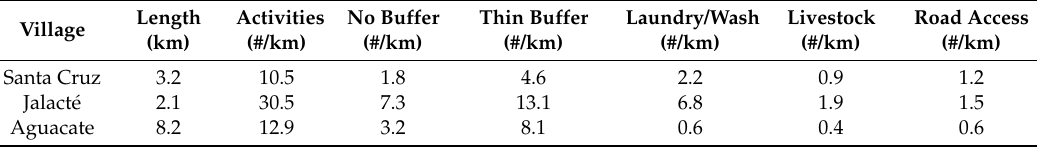
Table 4. Summary of human-activity mapping results. The table shows the length of river assessed and the density of various types of activities along that reach. The term “buffer” refers to riverside forests.